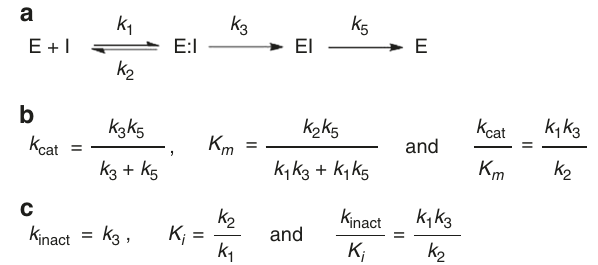
Fig. 8 Scheme for the covalent inhibition of α -glycosidases by cyclohexene carbasugar analogs. a Mechanistic scheme showing individual rate constants. b Kinetic expressions for hydrolysis of inhibitor. c Kinetic expressions for the covalent labeling stopped- fl ow